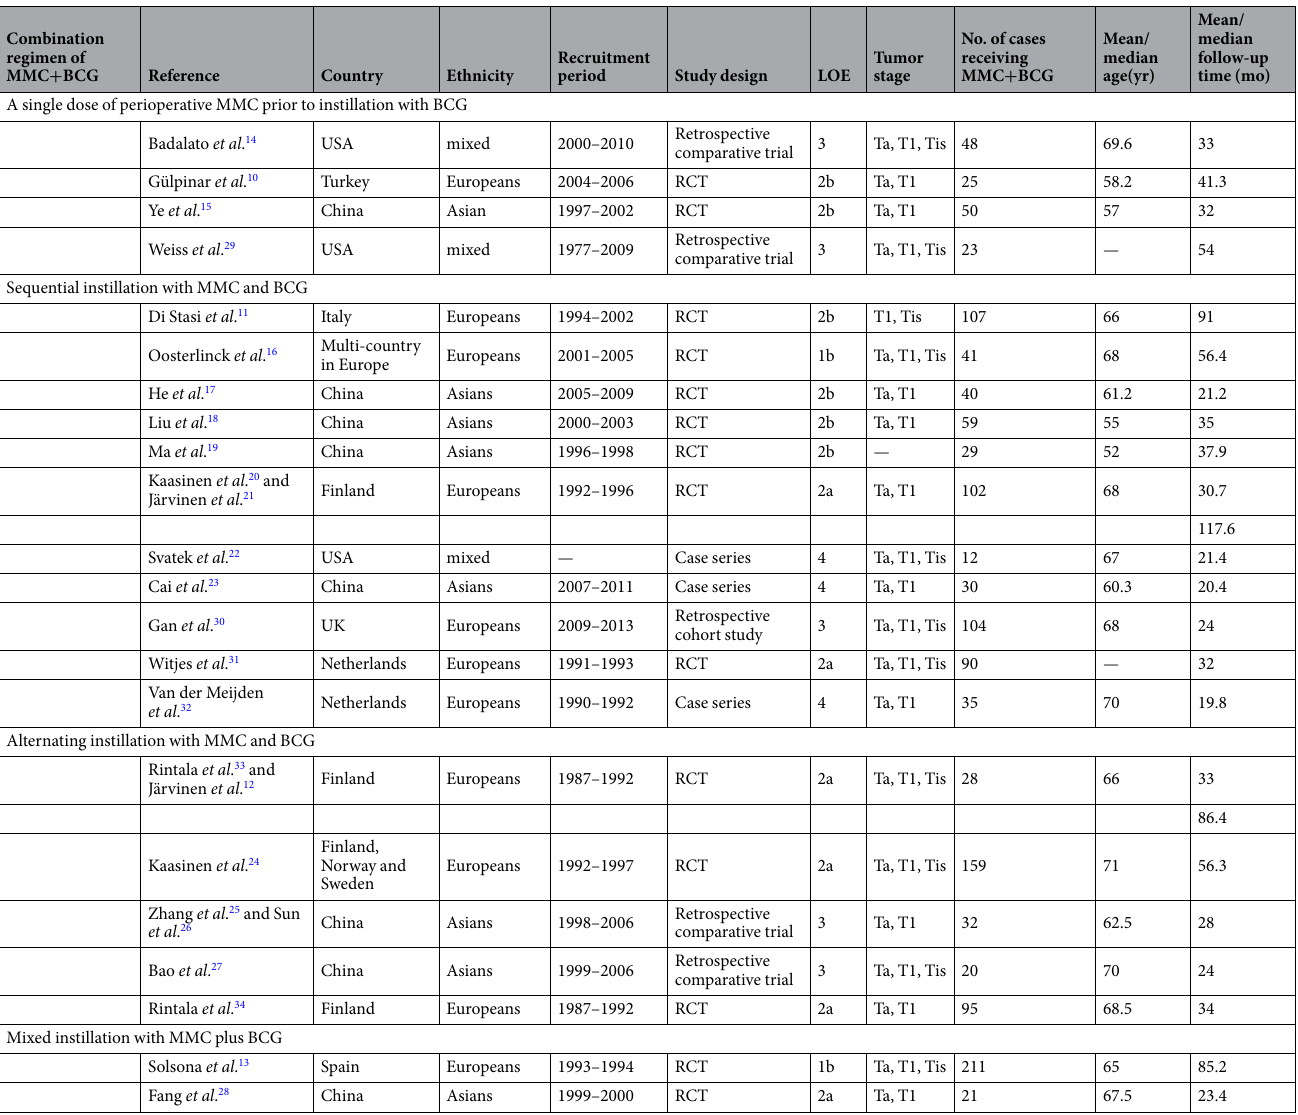
Table 1. The baseline characteristics of included studies. BCG = bacillus Calmette-Guerin; LOE = level of evidence; MMC = mitomycin C; RCT = randomized controlled